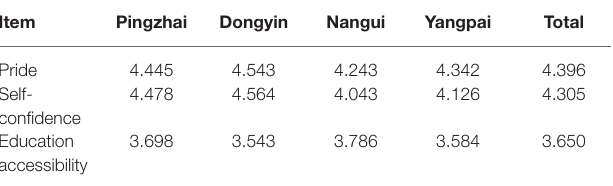
TABLE 8 | Means analysis of psychological perception.